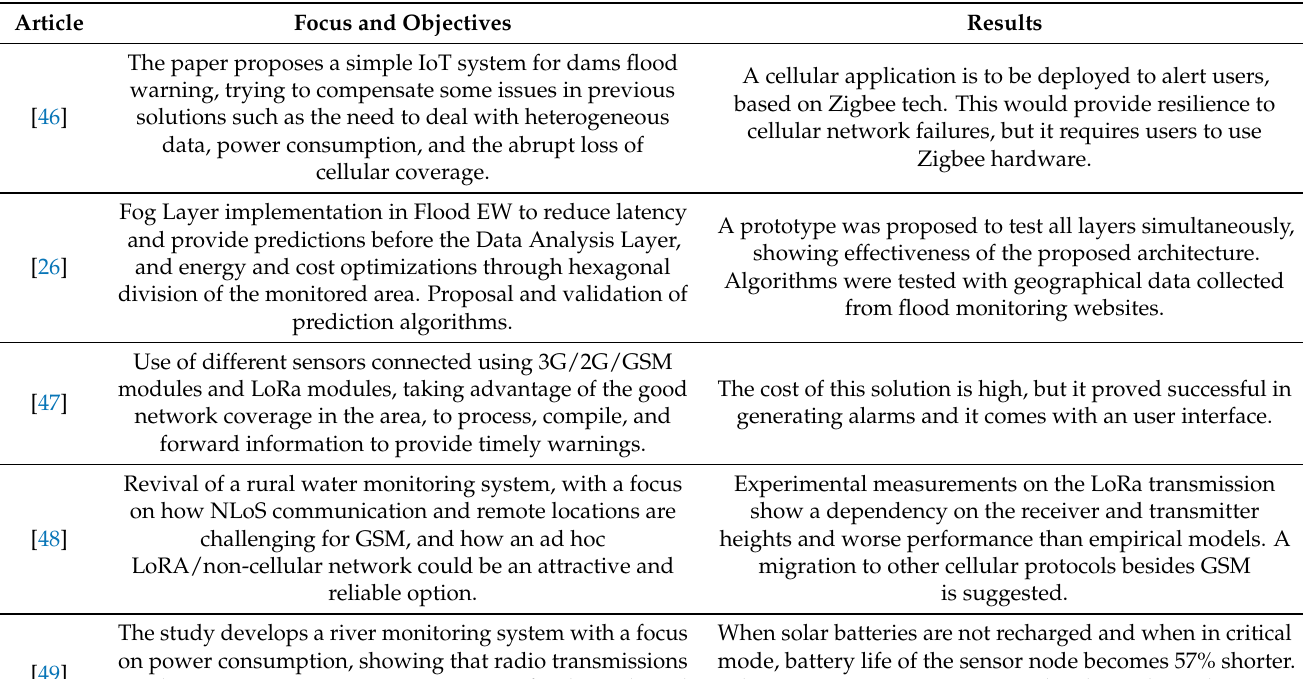
Table 1. Reviewed Articles in Flood